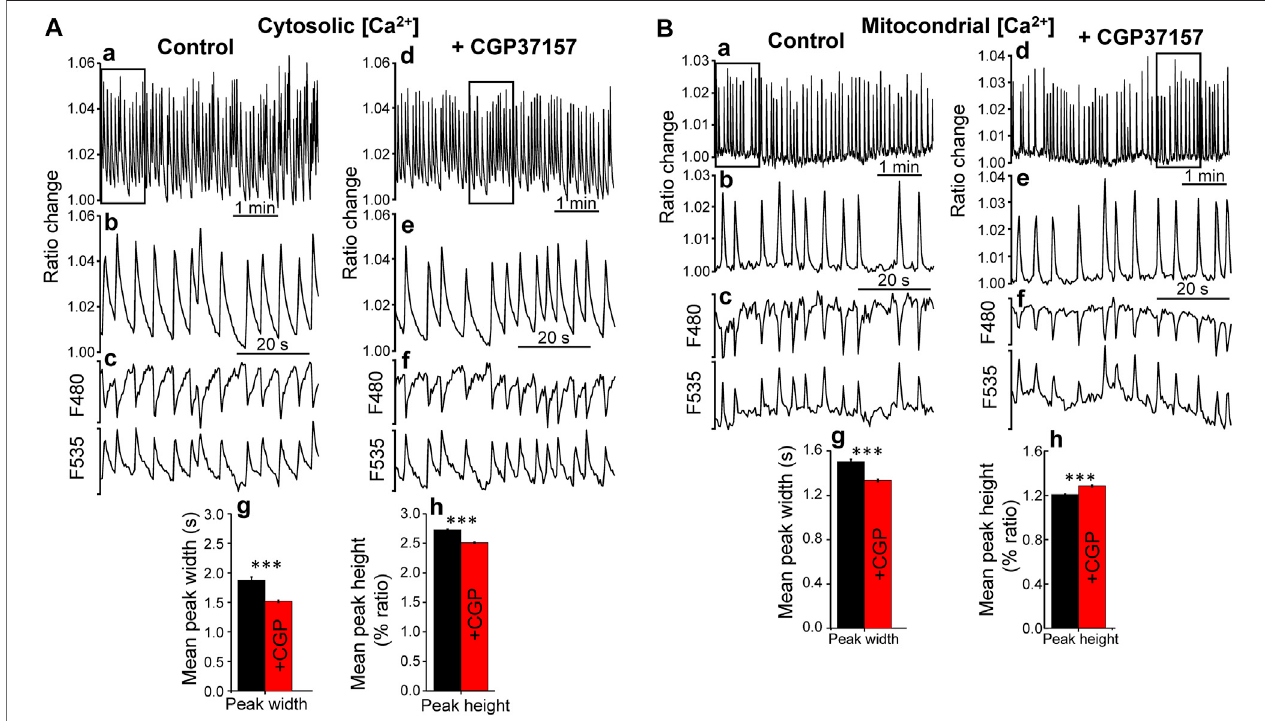
FIGURE 2 | Effect ofCGP37157 on C. elegans pharynx cytosolic (A) and mitochondrial (B) [Ca 2+ ]. Panels a and d show 5 min of typical records of cytosolic (A) or mitochondrial (B) [Ca 2+ ]oscillationsobtainedfrom C.elegans wormsatday5ofadultlifeeithertreated(paneld)oruntreated(panela)with50 µMCGP37157sinceday1 of adult life. Panels b and e show expanded the 1 min region marked with a square in the 5 min record of the panel above. Panels c and f show the single wavelength records with emission at 480 and 535 nm corresponding to the 1 min ratio records of the panels above, showing the expected mirror changes. Panels g and h show the mean peak width and mean peak height of pharynx cytosolic (A) or mitochondrial (B) [Ca 2+ ] oscillations. *** p < 0.001, ANOVA test, n (cid:2) 5,009 to 8,456 peaks